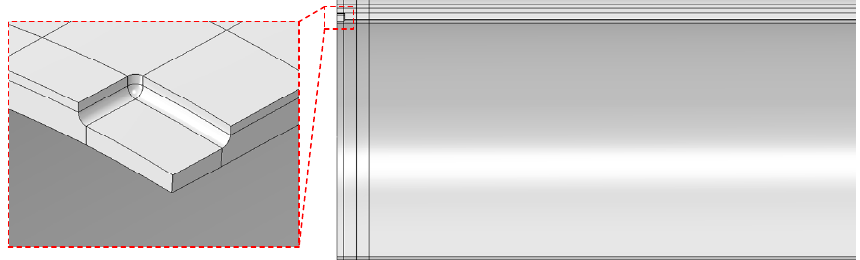
Figure 10. Corrosion interior edge chamfer.